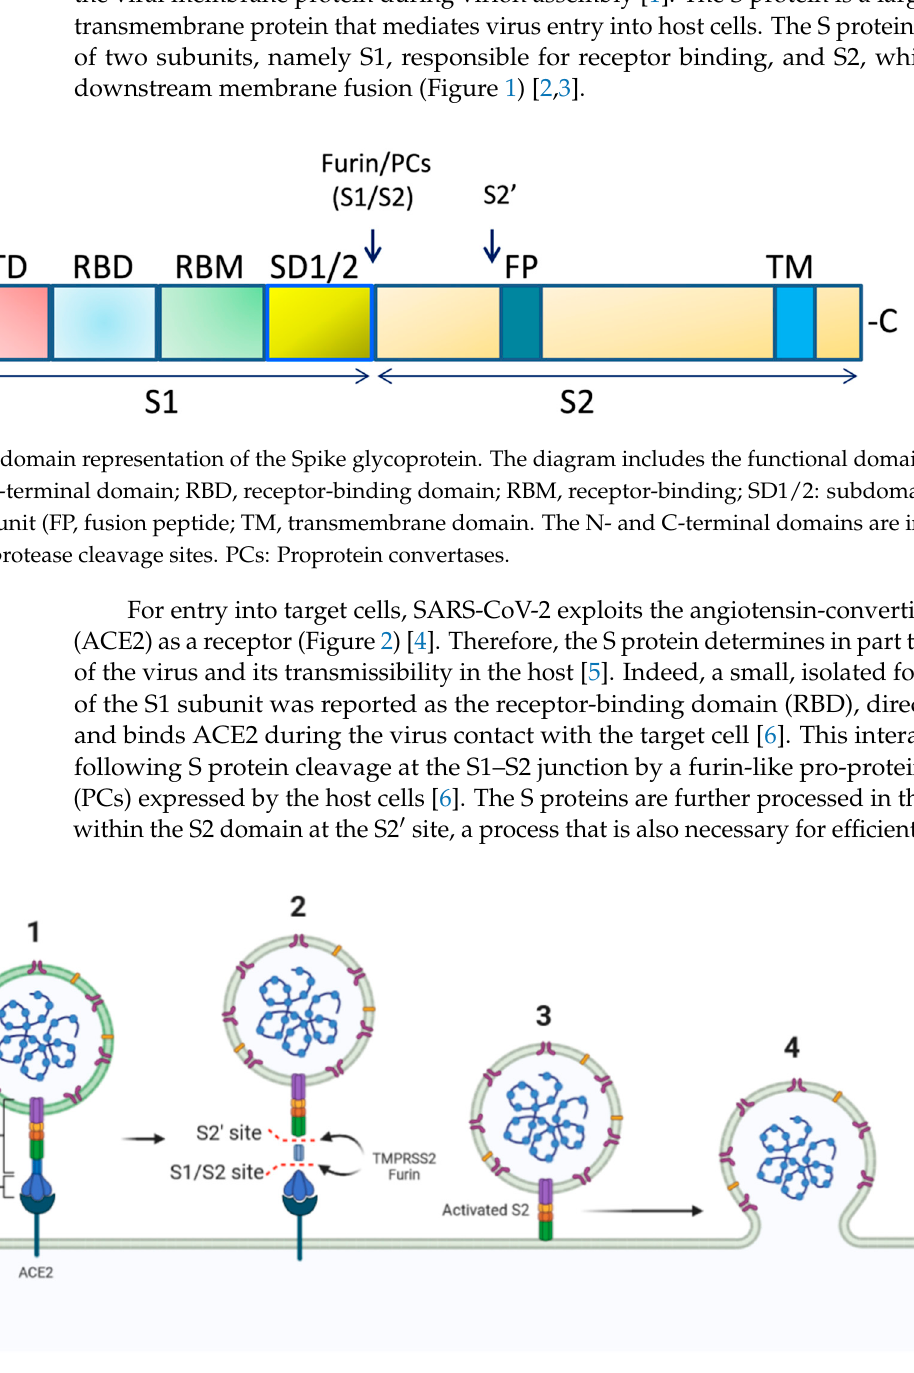
Figure 2. Schematic diagram of the Spike–ACE2 interaction. SARS-CoV-2 exploits the angiotensin-converting enzyme 2 (ACE2) to enter target cells. After receptor binding (1), the virus S protein is cleaved by proteases such as furin/TMPRSS2 into S1 and S2 subunits (2) that mediates S2-assisted fusion (3) and the release of the viral genome